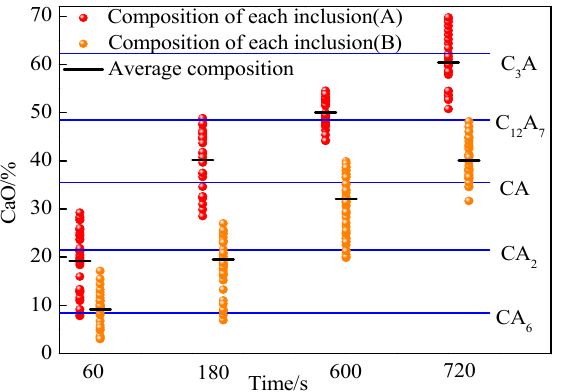
Figure 3. Compositions of inclusions detected in experiment steels (A and B) after calcium